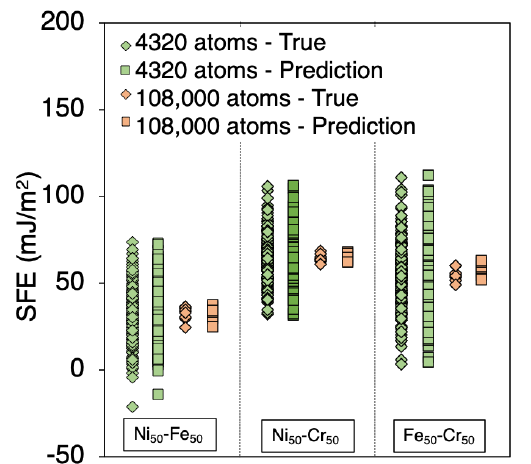
Figure 9. Comparison between true and predicted SFE for both 4320-atom and 108,000-atom supercells for Ni 50 -Fe 50 , Ni 50 -Cr 50 , and Fe 50 -Cr 50 compositions. Significantly reduced various is observed in 108,000-atom compared to 4320-atom supercells. The variation in the ML predictions is of the same range as that of the true-data for both structure sizes, indicating the ability of the model to learn and predict for various nearest neighbor environments. Color scheme: green diamonds—true data for 4320-atom supercell, green squares—predicted data for 4320-atom supercell, orange diamonds—true data for 108,000-atom supercell, and orange squares—predicted data for 108,000-atom supercell.